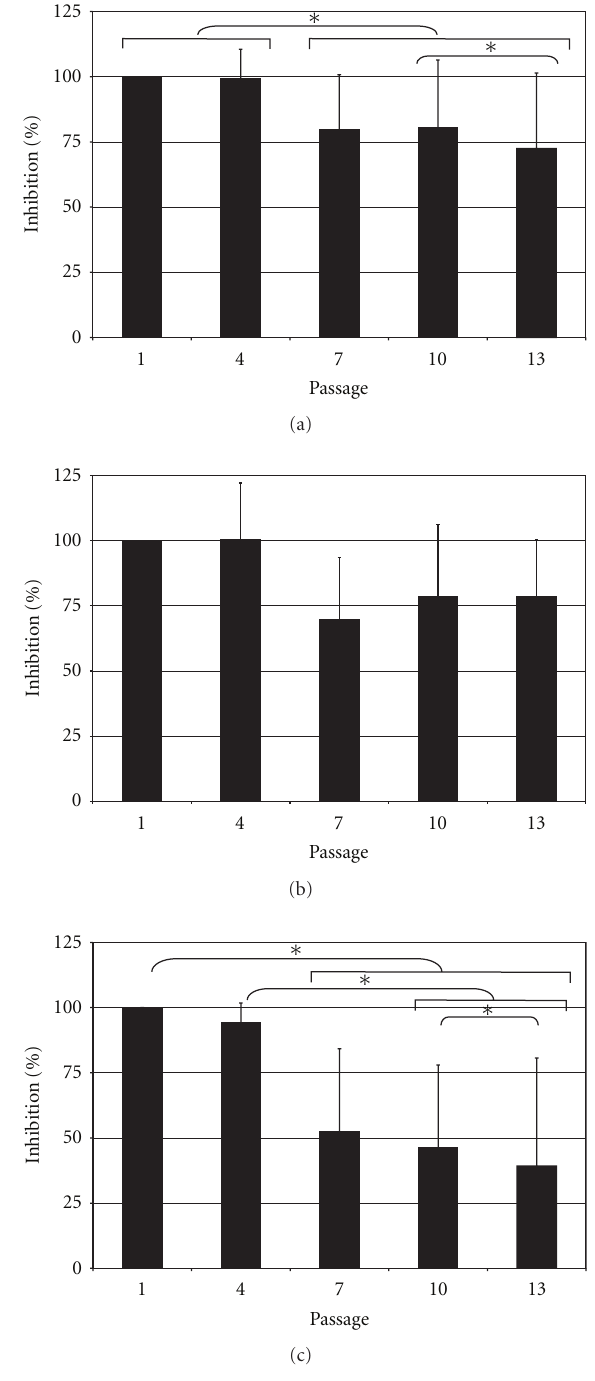
Figure 5: E ff ect of time-in-culture on the immunosuppressive activity of hMSCs. Immunosuppressive activity in conditioned medium from IL-1 β -stimulated hMSCs at di ff erent passages cul- tured under control conditions. Values are normalized to the inhibition observed conditioned medium from first passage hMSCs. The mean and standard deviation for all 5 hMSC preparations are displayed in (a); the 3 hMSC preparations that exhibited sustained activity are displayed in (b); the mean and standard deviation for the 2 hMSC preparations that exhibited decreased activity after 4 passages are displayed in (c). Asterisks indicate significant di ff erences in one-tail paired t -test; ∗ P < .